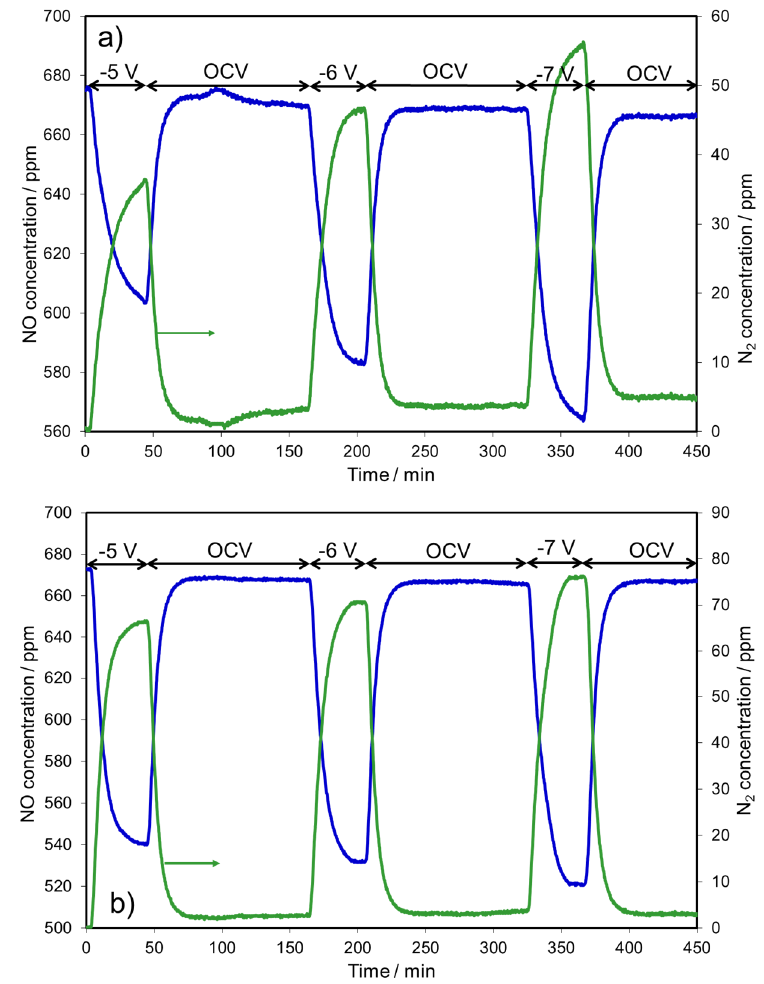
Figure 5. Variations of NO and N 2 concentrations as a function of time at ( a ) 450 ◦ C and ( b ) 500 ◦ C. Reactive mixture: NO/NO 2 : 680 ppm/10 ppm in He.